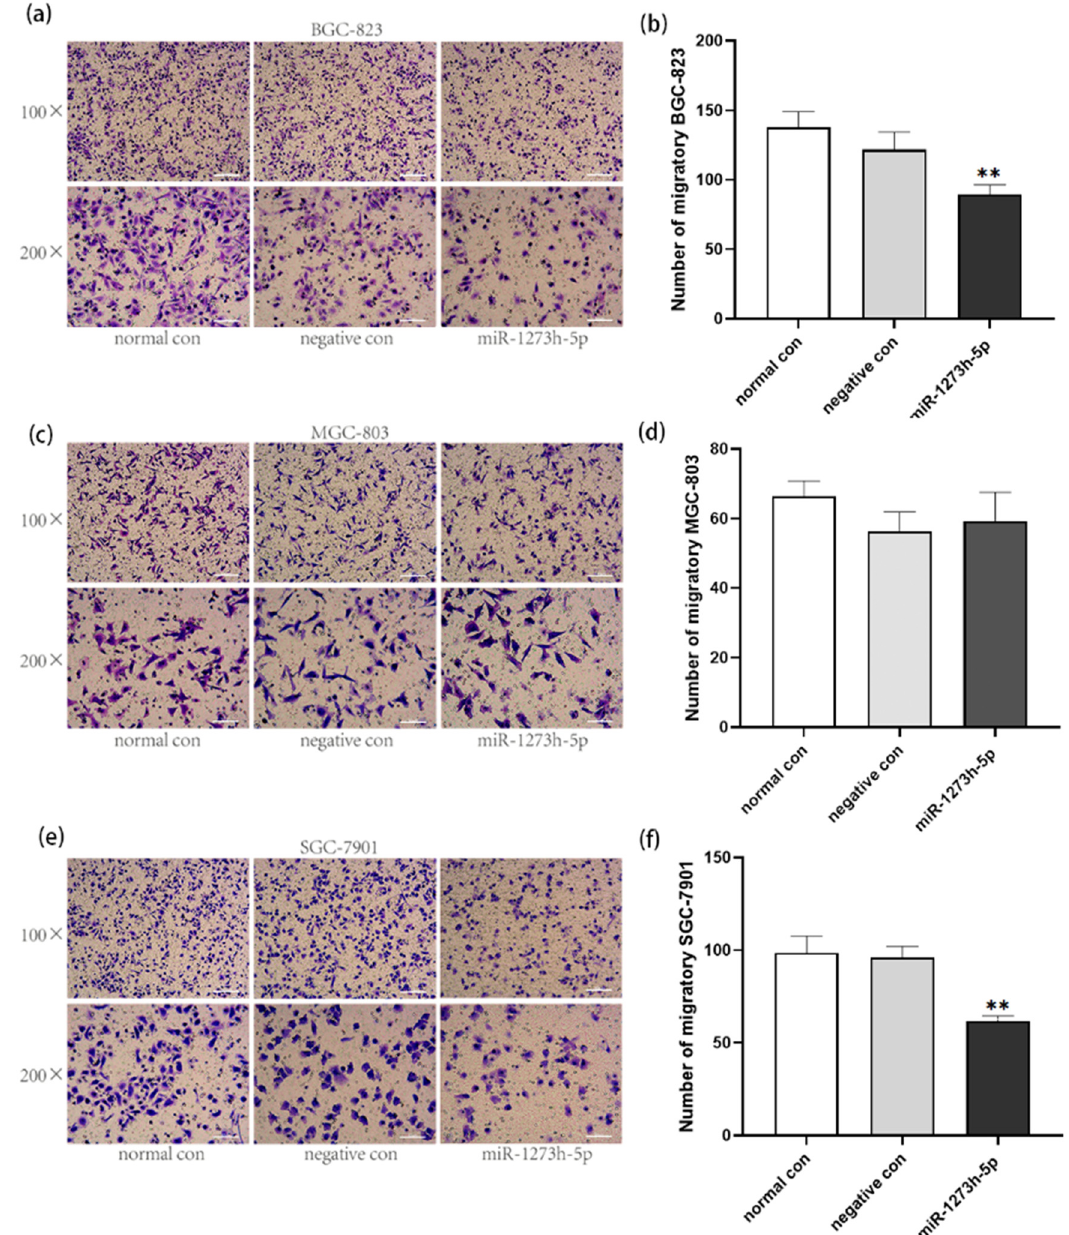
Figure 4: E ff ect of miR - 1273h - 5p on GC cell migration. ( a and b ) E ff ect of miR - 1273h - 5p on the migration of BGC - 823 cells at 24 h after transfection determined by transwell assay. Compared to the negative control, the ratio of migration was signi fi cantly reduced in the miR - 1273h - 5p group. ( c and d ) Impact of miR - 1273h - 5p on the migration of MGC - 803 cells at 24 h after transfection determined using transwell assay. ( e and f ) Impact of miR - 1273h - 5p on the migration of SGC - 7901 cells at 24 h after transfection determined by transwell assay. The migratory ratio of the miR - 1273h - 5p group revealed signi fi cantly decreased contrast with negative control. Pictures of each group included two kinds of speci fi cations with 200 × used for statistics. Scale bars have been depicted. All data were expressed as M ± SD from three independent experiments when compared with the negative control group, ** P <